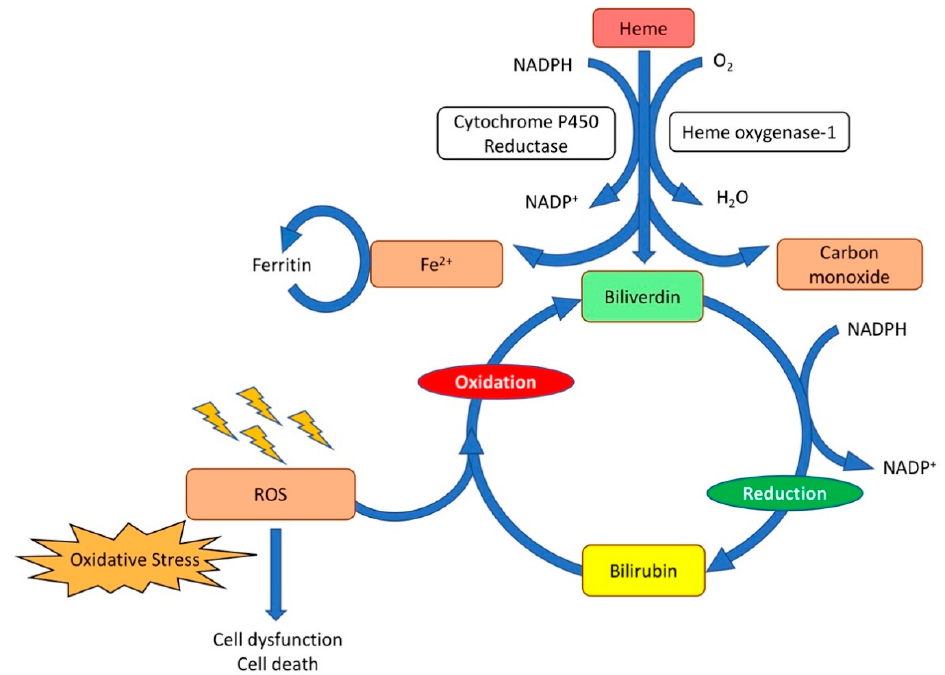
Figure 2. Catabolism of heme. Heme oxygenase is the rate-limiting enzyme in the catabolism of heme. In connection with cytochrome P450 reductase and in the presence of NADPH and three molecules of molecular oxygen (O 2 ) per heme molecule, it catalyzes the oxidative cleavage of heme to render equimolar amounts of biliverdin, ferrous iron (Fe 2+ ), and carbon monoxide. Ferrous iron (Fe 2+ ) is sequestered into ferritin for storage. In the second reaction, the green pigment biliverdin is reduced to the yellow pigment bilirubin by biliverdin reductase. Bilirubin can serve as an antioxidant and reverts back to biliverdin. The biliverdin–bilirubin–biliverdin cycle is very powerful to detoxify ROS.